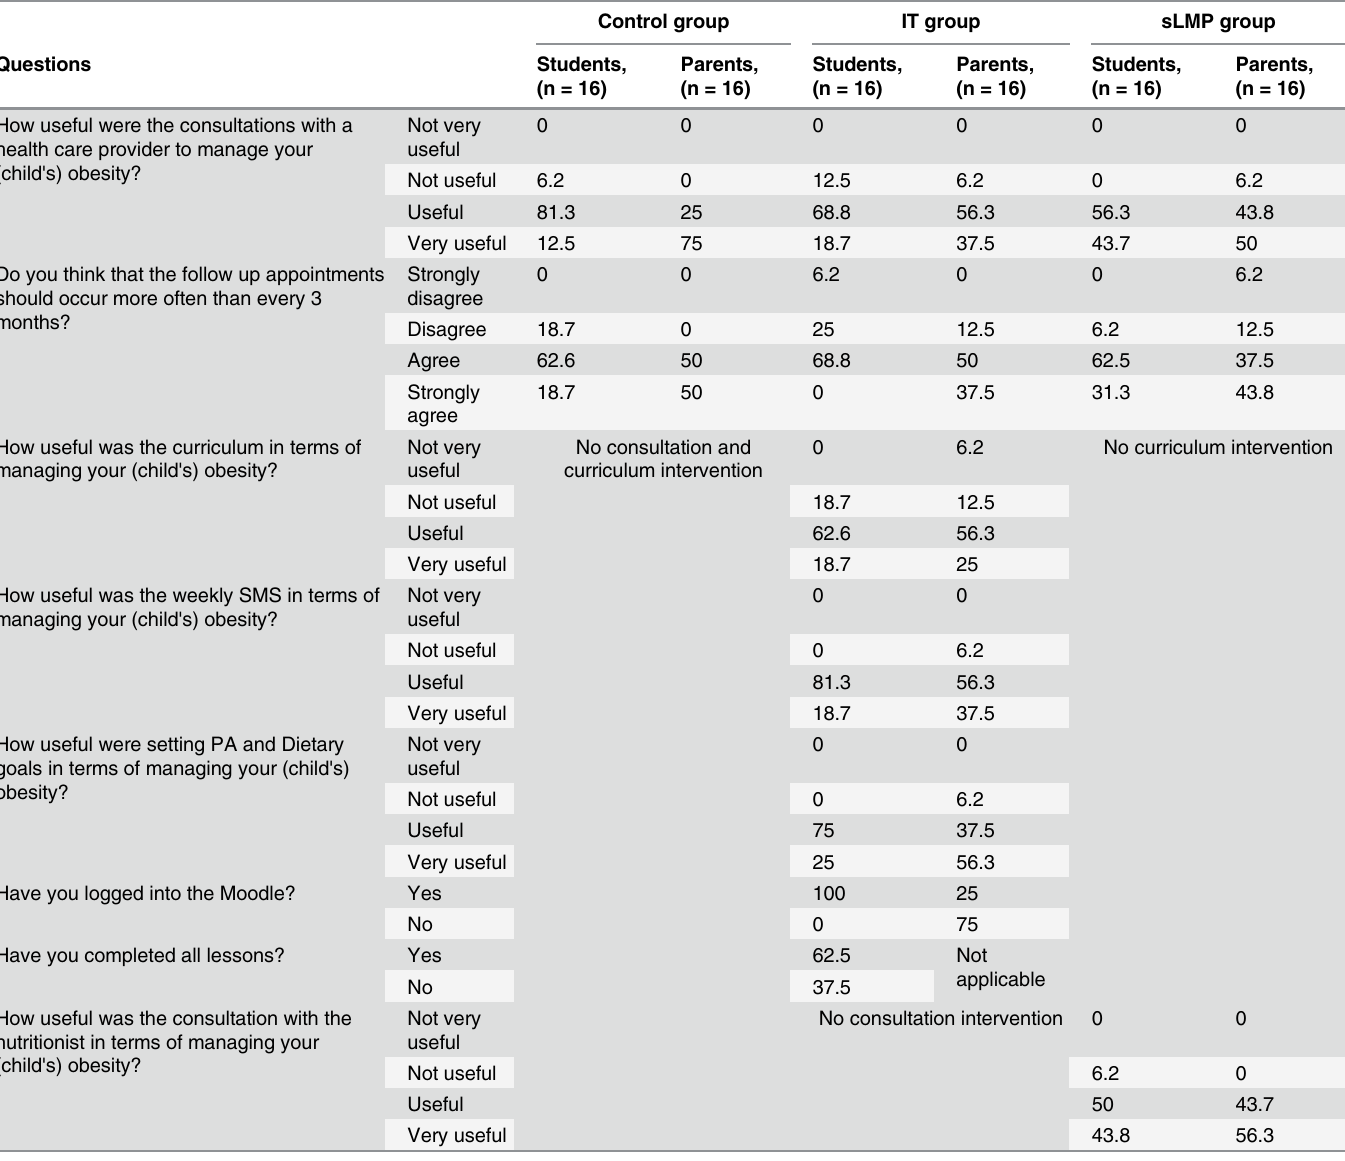
Table 3. Summary of satisfaction levels with usual care, nutrition counselling, curriculum and cell phone communication from the control, internet (IT) and simplified lifestyle modification programme (sLMP) groups completed at final visit (week